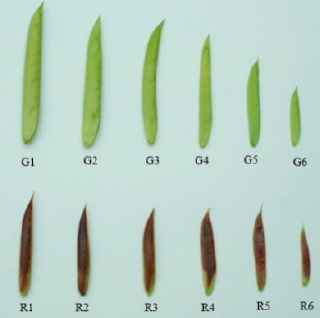
Figure 6. Representative samples of green ( top ) and red ( bottom ) pods. The sample pods are as